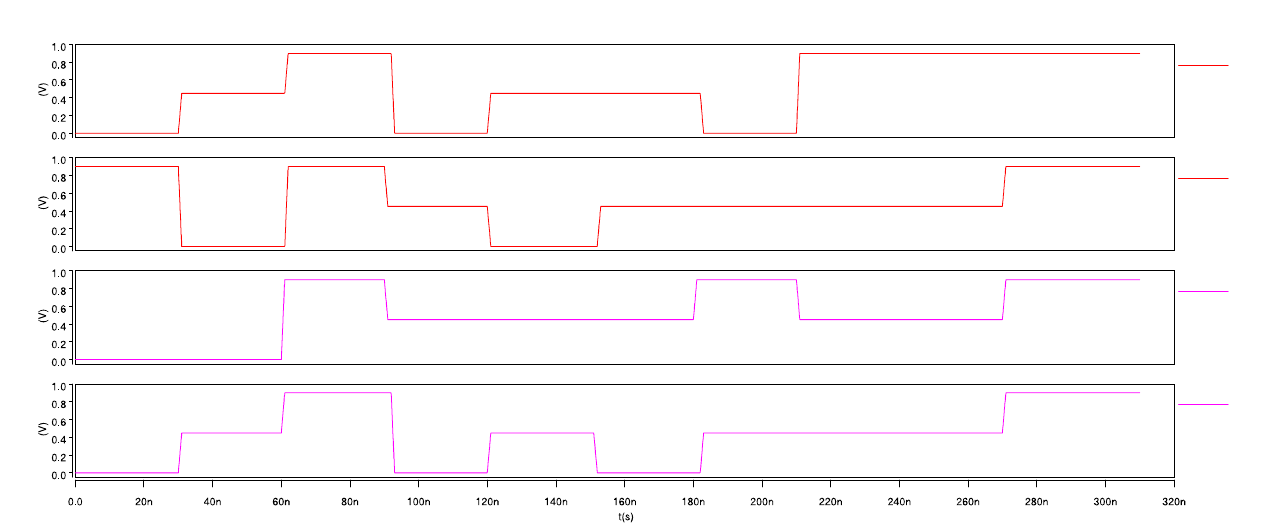
Figure 13. Input waveforms of CNTFET-RRAM ternary adder–subtractor module.